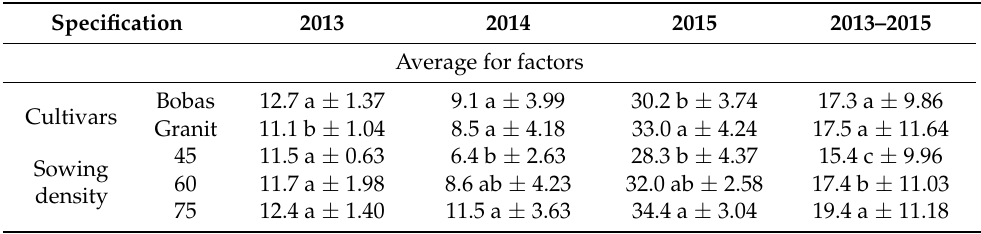
Table 11. Calcium accumulation in the faba bean straw (kg ha − 1 ) as influenced by the examined factors during the study years